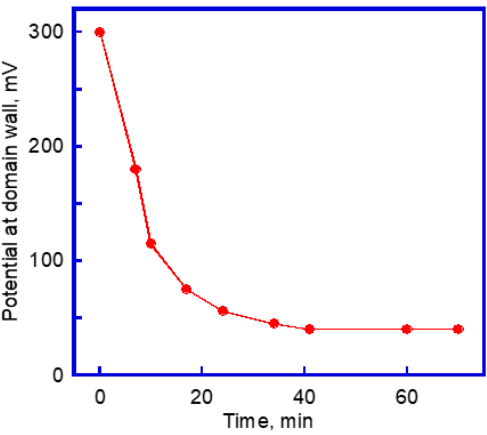
◦ a-c domain wall potential change over Figure 3. The intensity of 90° a-c domain wall potential change over time. Figure 3. The intensity of 90